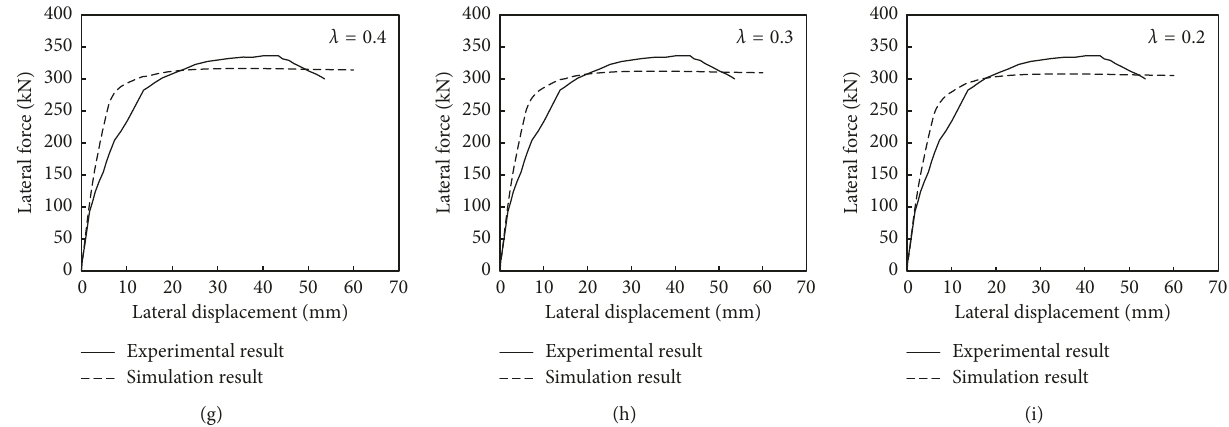
Figure 19: Comparison between pushover analysis results and experiment results under different stiffness reduction conditions.